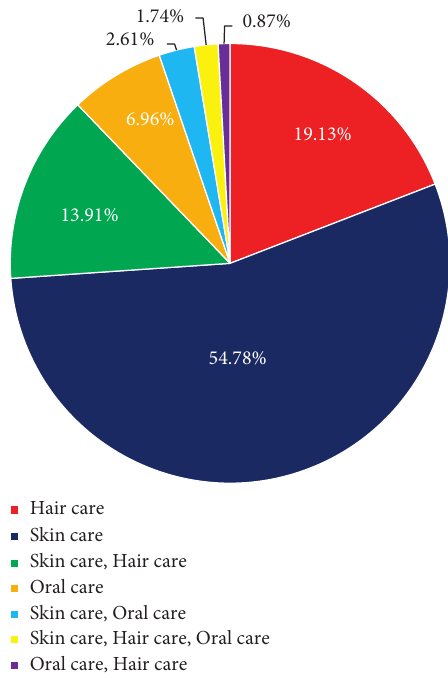
Figure 2: Plants usage in different cosmetic product categories.